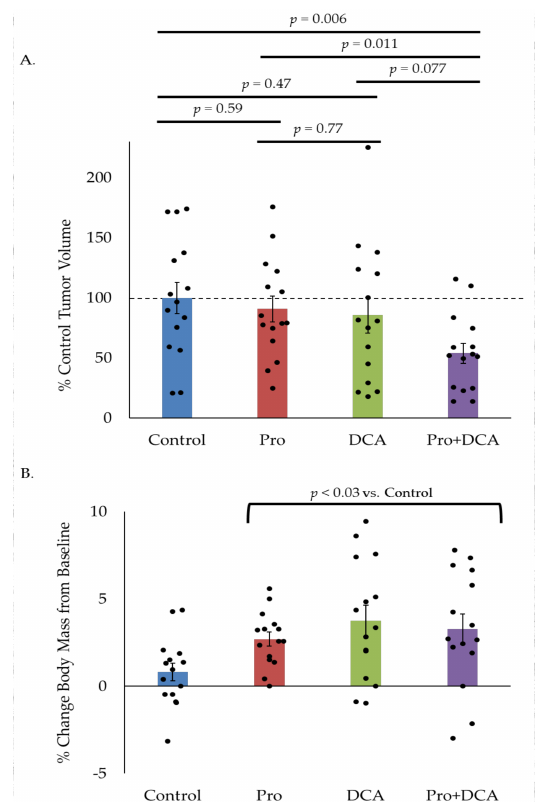
Figure 6. The combination of propranolol and DCA delays tumor growth in vivo. Average tumor volume ( A ) and percent change in body mass ( B ) in mice implanted with MLM3 tumors and treated daily with propranolol, DCA, or the combination. Values in (A) reflect percent tumor volume relative to control animals. Values in (B) reflect percent change in body mass relative to pre-tumor baseline. Each bar represents mean +/ − SEM of n = 15 mice. Scatter points represent individual animals. p -values reflect t -test